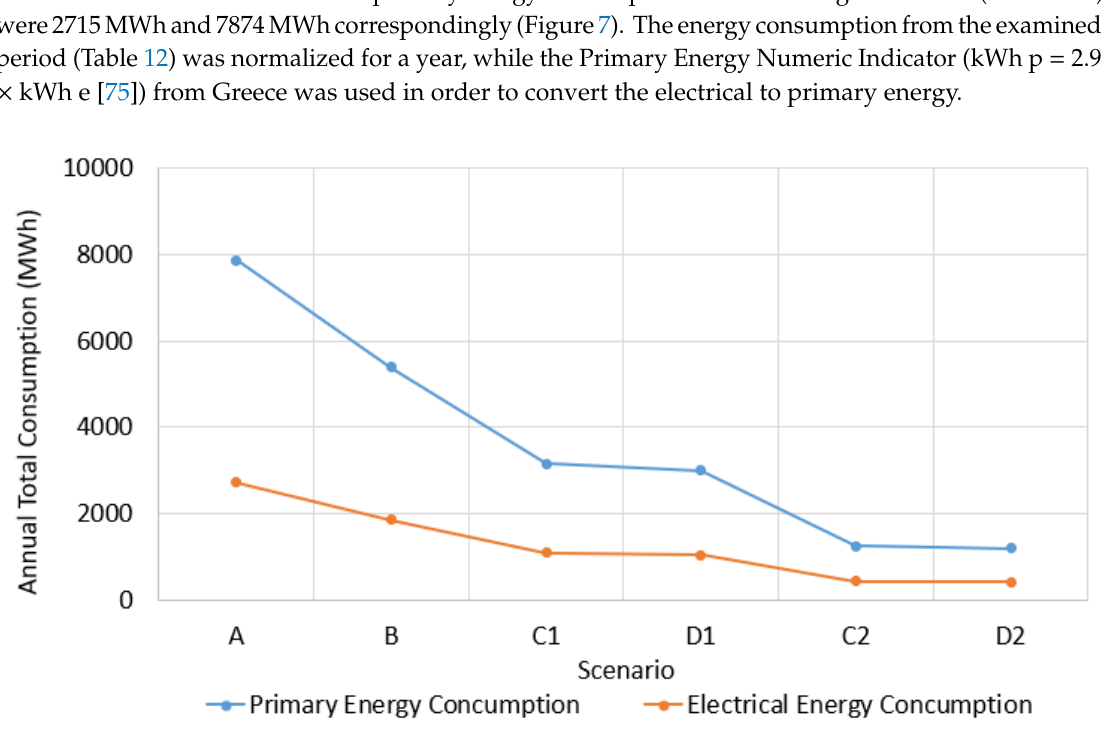
Table 12. Total energy consumption, annual CO 2 emission (using the emission factor 1058.95